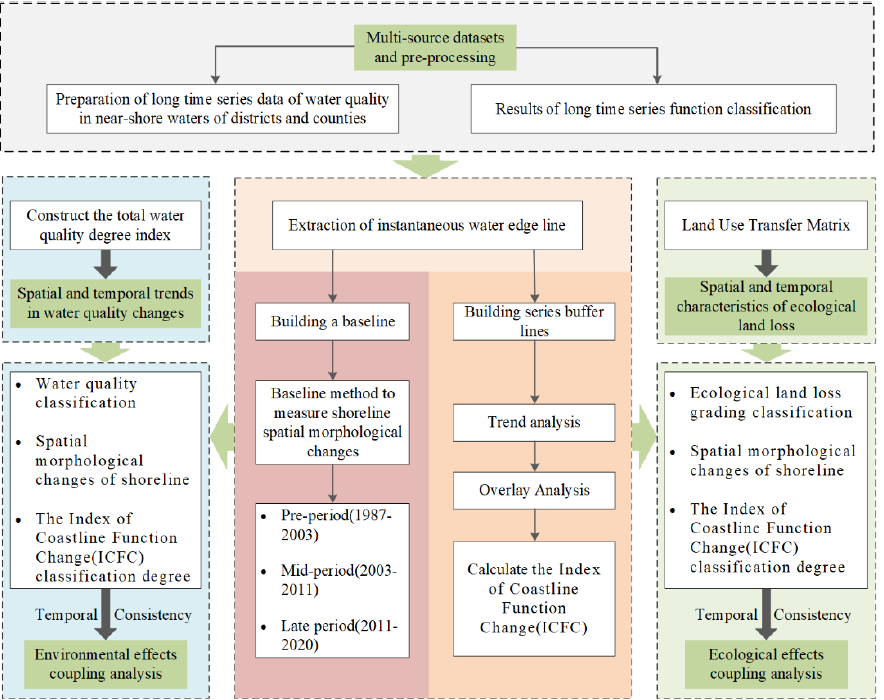
Figure 2. Technology flowchart of long-time-series land-use function classification, coastline changes detection, and eco-environmental effect evaluation .